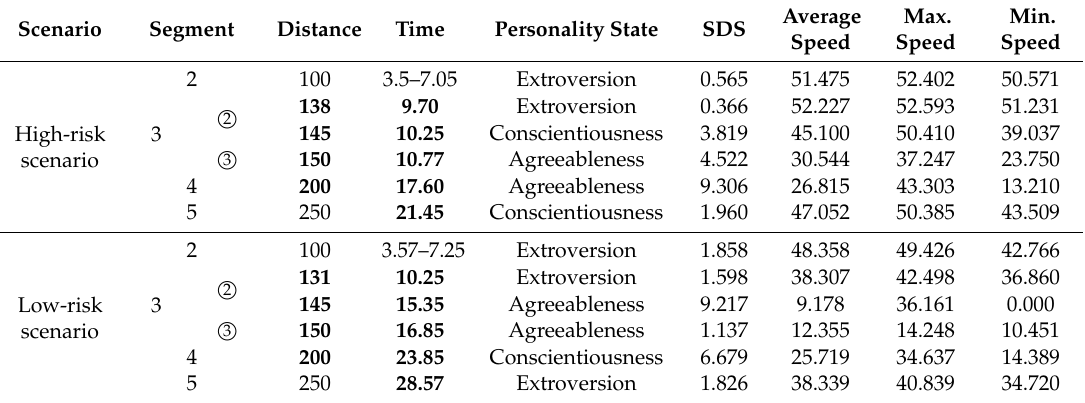
Table 6. Changes in personality states and data of relevant indexes in high- and low-risk scenarios. Scenario